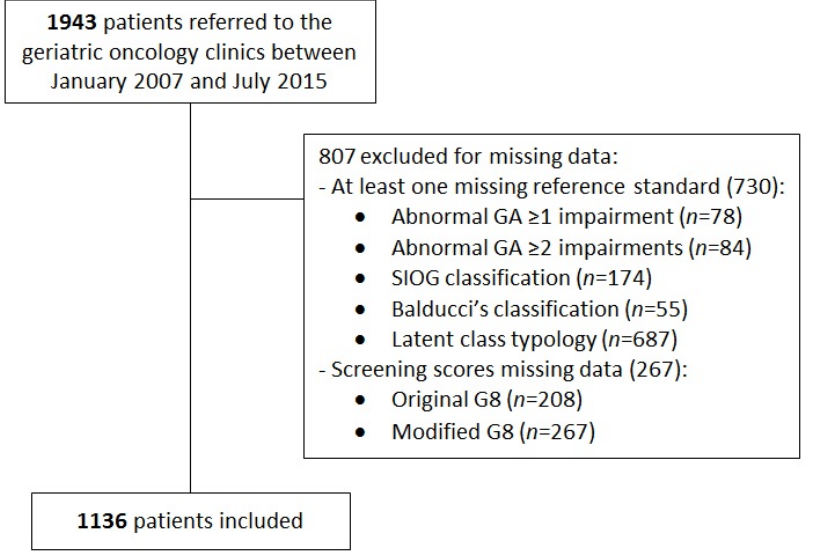
Figure 1. Flow diagram of patients in the study. GA, geriatric assessment; SIOG, International Society of Geriatric Oncology.